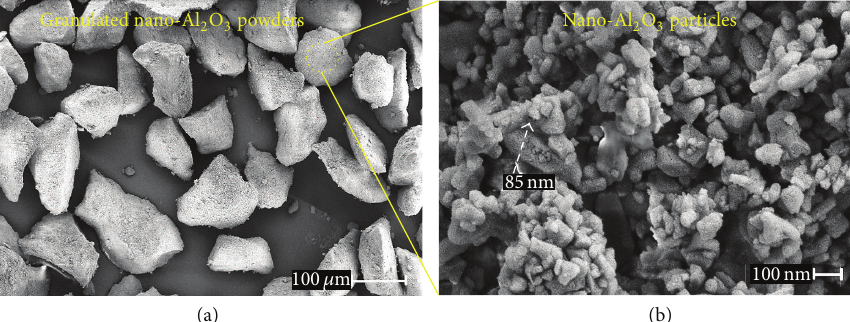
Figure 3: FESEM images of nano-Al 2 O 3 powders after granulation with different magnifications (a) × 100 and (b) × 20.0 K.